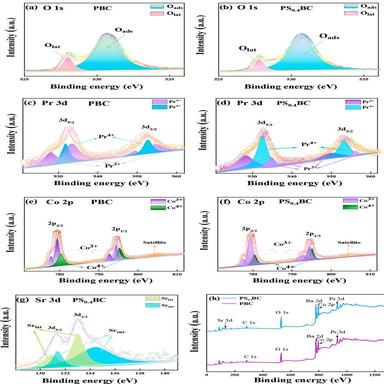
The corresponding peaks of PBC and PS0.4BC samples (a–b) O 1 s; (c–d) Pr 3d; (e–f) Co 2p; (g) Sr 3d; (h) the changes of each element in the XPS spectrum.